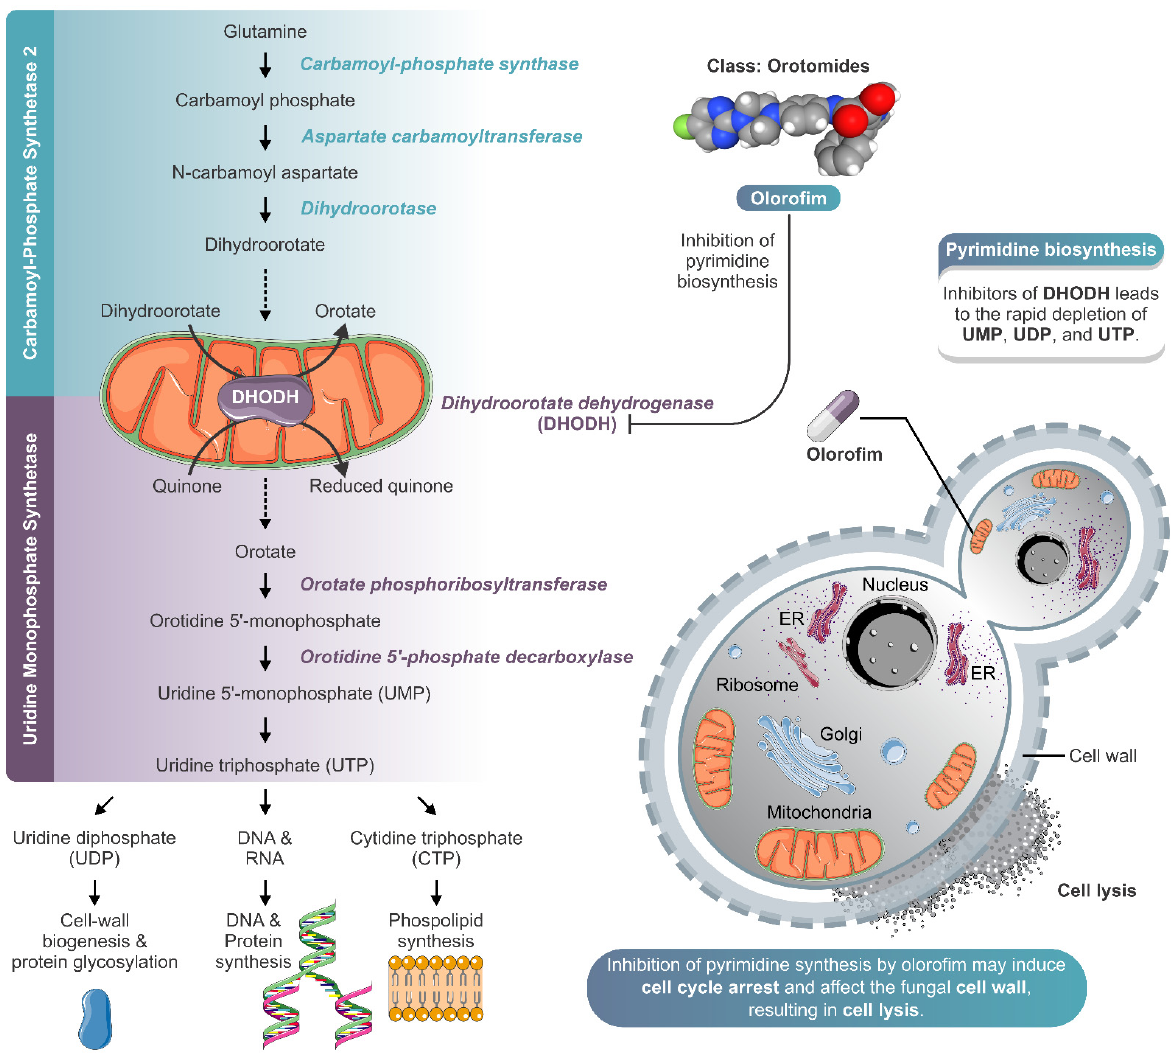
Figure 5. Schematic model of olorofim action against Sporothrix yeasts. Olorofim belongs to a new class of antifungal agents called the orotomides, which inhibits fungal pyrimidine biosynthesis. Olorofim inhibits dihydroorotate dehydrogenase, an enzyme of de novo pyrimidine biosynthesis, leading to the rapid depletion of uridine 5 (cid:48) -monophosphate (UMP), uridine diphosphate (UDP), and uridine triphosphate (UTP). The reduction in UTP levels can cause a decrease in cell wall biogenesis, protein glycosylation, and synthesis of DNA, protein, and phospholipid. In Sporothrix yeast cells, the inhibition of pyrimidine synthesis by olorofim may induce cell cycle arrest and affect the fungal